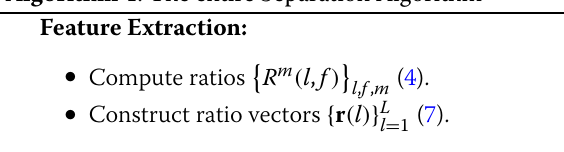
Algorithm 4: The entire Separation